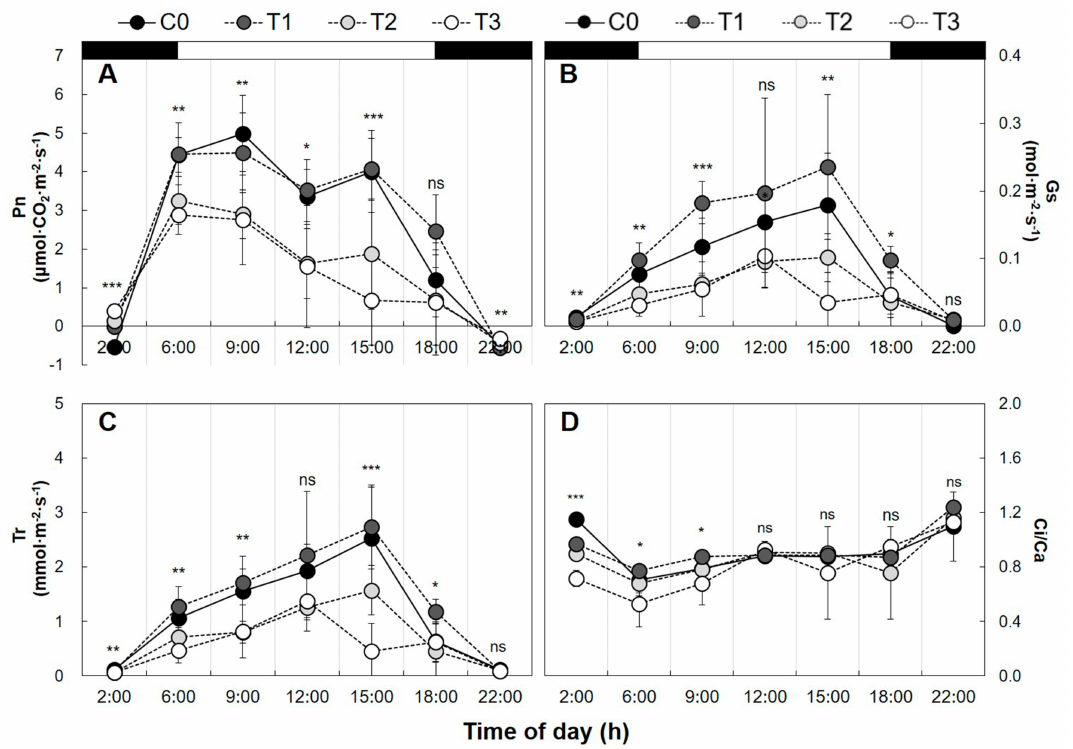
Figure 5. Diurnal patterns in leaf gas exchange parameters of yellow-poplar leaves during the 13-month treatment period. The dark period has a gas exchange rate by artificial night lighting. ( A ) Net photosynthetic rate (Pn), ( B ) stomatal conductance (Gs), ( C ) transpiration rate (Tr), and ( D ) ratio of intercellular (Ci) to atmospheric (Ca) CO 2 concentration (Ci/Ca ratio) of yellow-poplar plants exposed to the natural day/night cycle (C0) and the day/night with artificial lighting cycle (T1, T2, and T3). The black solid circles ( ), gray solid circles ( ), light gray solid circles ( ), and hollow circles ( represent C0, T1, T2, and T3, respectively. Black and white boxes at the top indicate the dark and light phase, respectively, in the daily cycle. The x -axis represents the time of day (h). Data points represent mean ± SD ( n = 5). Asterisks represent a significant difference among treatments (* p < 0.05; ** p < 0.01; *** p < 0.001; ns, not